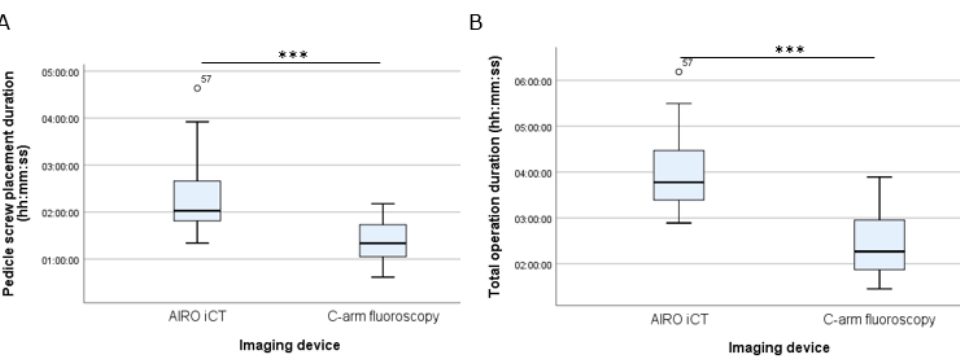
Figure 8. Time efficiency of an MI-PLIF surgery. ( A ) Duration of pedicle screw insertion (in hh:mm:ss) compared between surgeries assisted by iCT ( n = 24) and C-arm fluoroscopy ( n = 18). ( B ) Total operation duration (in hh:mm:ss) compared between surgeries assisted by iCT ( n = 29) and C-arm fluoroscopy ( n = 43). Outliers are marked as “°” on the boxplot. Significance ( p < 0.001) is indicated with “***” above the two boxplots.